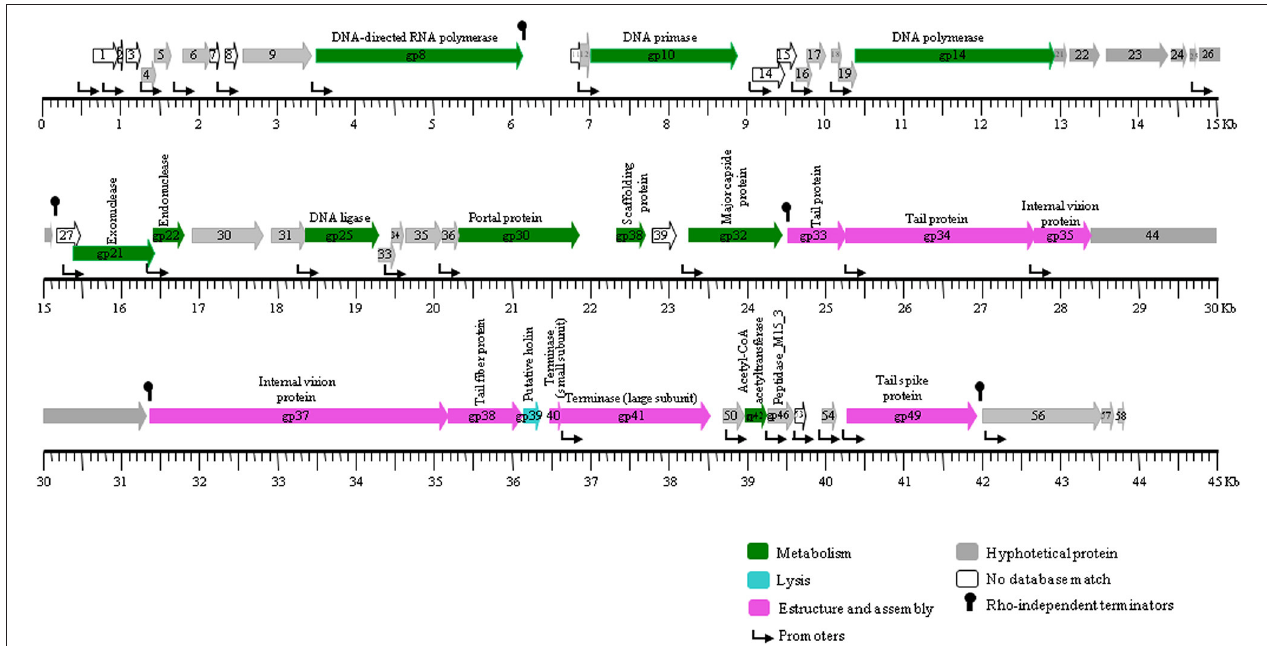
FIGURE 3 | Genomic structure of UAB_Phi78 including the Rho-indepedent terminators. Arrows represent genes, and the different colors identify the functional category into which the homologous genes were classified. Gene functions are indicated where they are known. The color code for gene function is provided at the bottom of the figure. ORFs are numbered consecutively from left to right as described in Table 2 , and are indicated by arrows pointing to the direction of